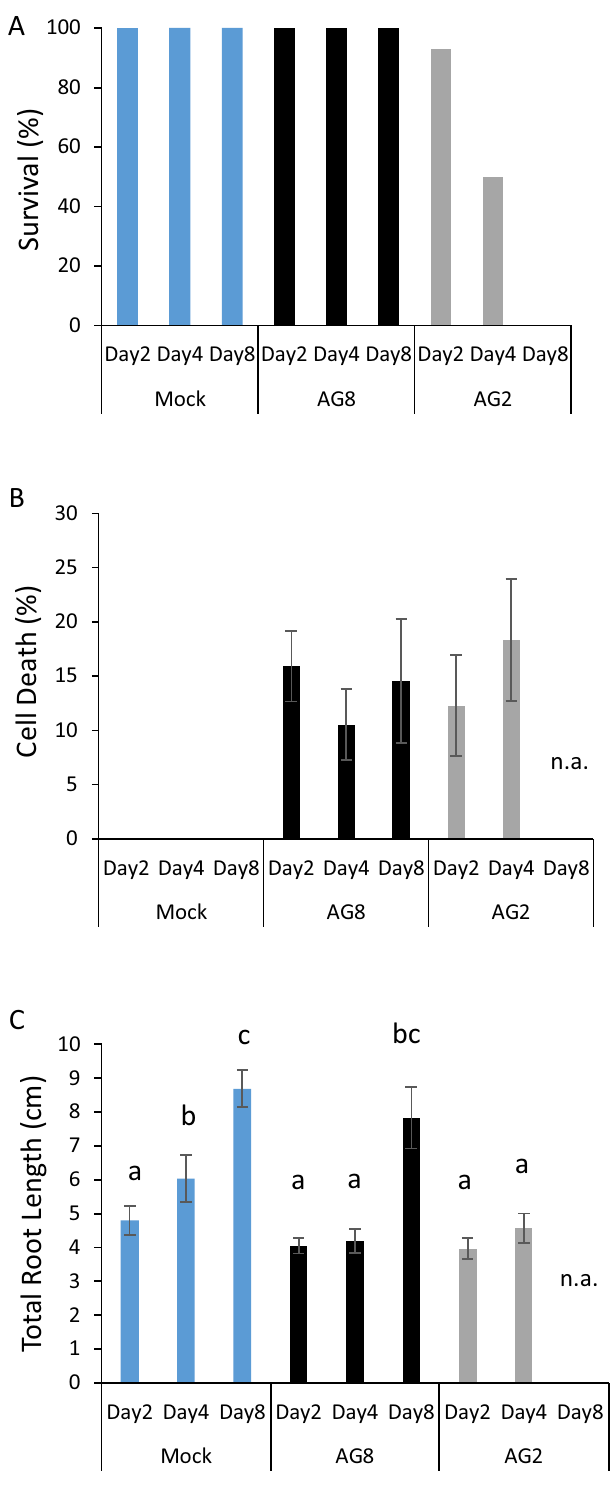
Figure 3. AG8 and AG2-1 isolates cause equivalent levels of cell death on Arabidopsis roots. ( A ) Survival percentage of the ten Arabidopsis plants at each timepoint that were either mock infected or infected with either AG8 or AG2-1. 10 plants were used for each timepoint and treatment for a total of 90 plants. The infection was repeated multiple times and showed similar survival percentages in response to AG8 and AG2. ( B ) The percentage of root cell death compared to the total root length using propidium iodide staining. ( C ) Total root length measurements. The survival, root length and cell death percentage were measured from 10 plants per treatment at each timepoint. Survival of AG2-1 infected plants was also scored at 8 days post infection, however root length and cell death was not assessed (n.a.) as the plants were unable to be isolated from the pots due to disintegration of the above ground tissue. Bars with differing letters represent a significant difference using a one-way ANOVA ( p < 0.05) and Tukey’s HSD test. Error bars represent standard